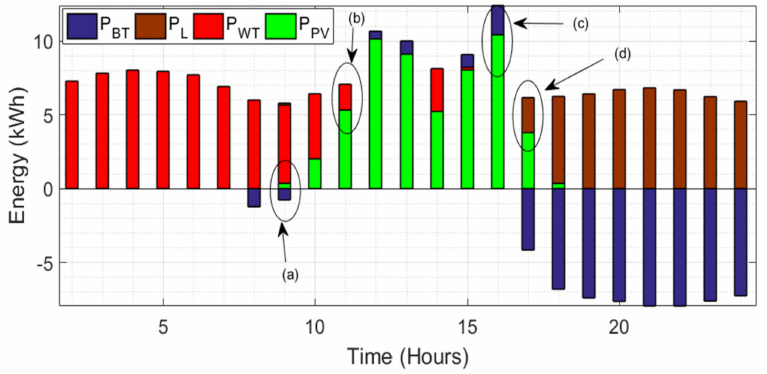
Figure 11. Daily output power from PV, WT, BT, and